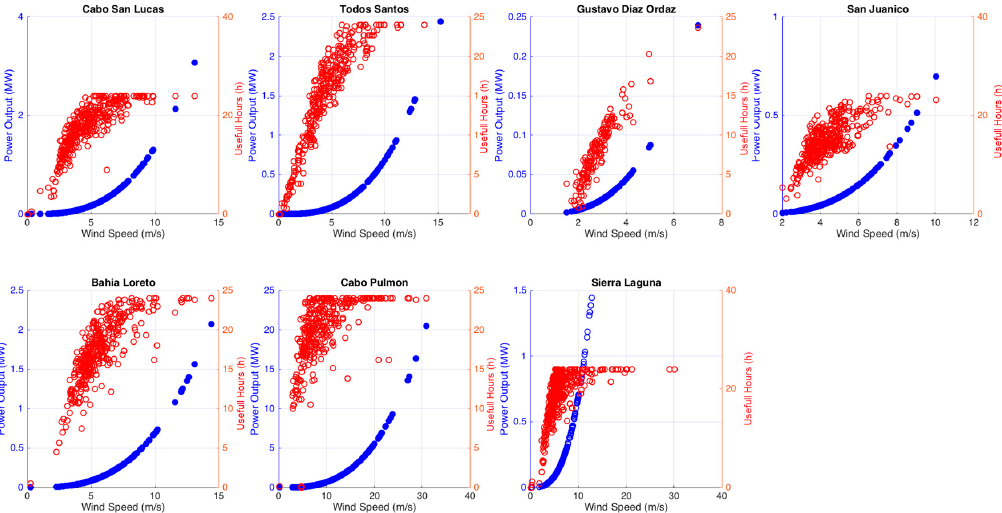
Figure 17. Power output, useful hours and wind speed by AMSs Baja California Sur.